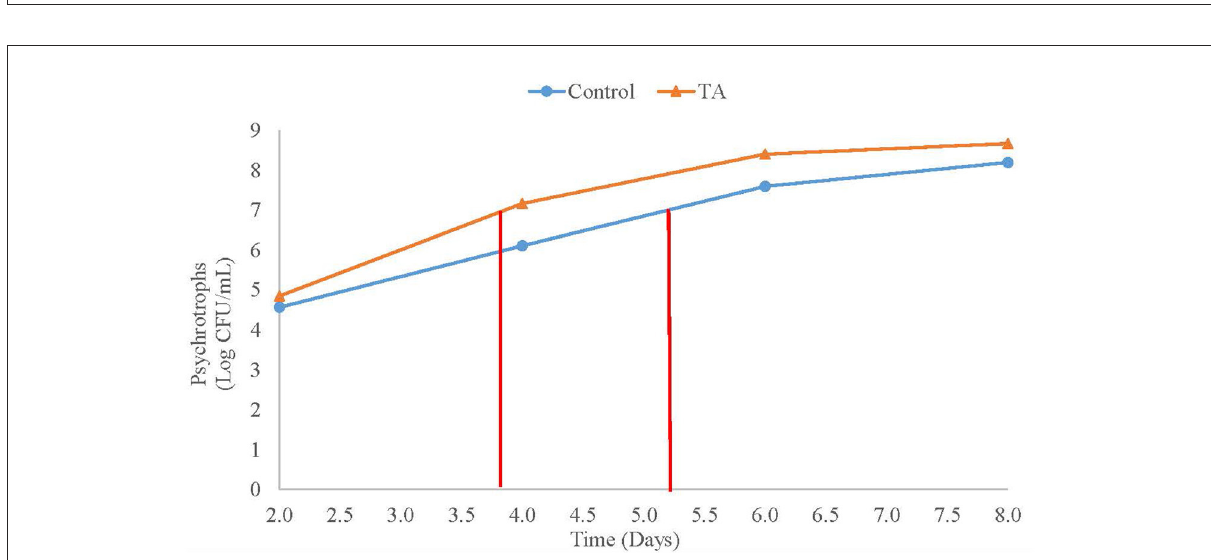
FIGURE10 Psychrotroph shelf-life of simulated less-than-truckload temperature abused (TA; 2h at 4 ◦ C then 2h at 25 ◦ C), and control chicken breast filets kept in simulated retail conditions.